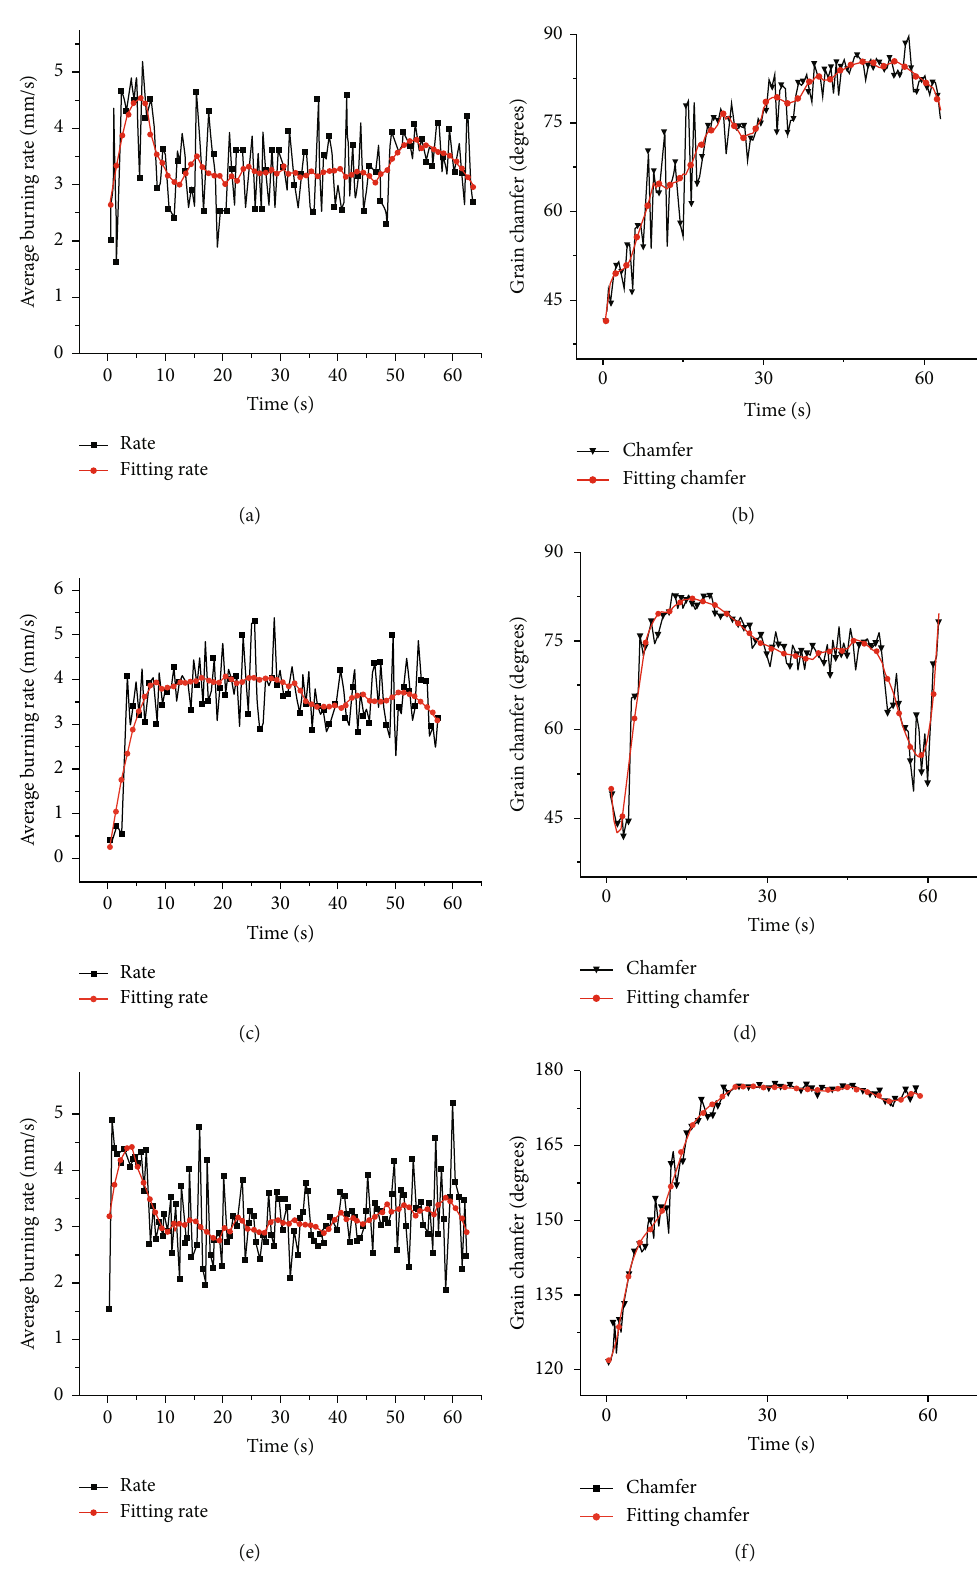
Figure 9: Time-based changes in grain chamfer and average burning rate of center line. (a), (c), and (e), respectively, represent the curves of time-based changes in the average burning rate of the center line for Test2, Test3, and Test4; (b), (d), and (f), respectively, represent the curves of time-based changes in the chamfer for Test2, Test3, and